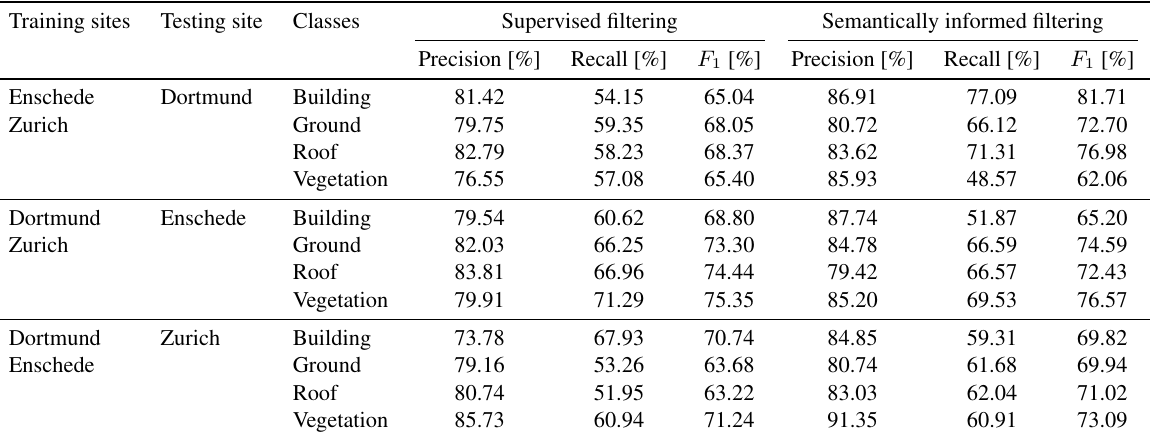
Table 3: Results for filtering approaches trained on two data sets and applied to the third. Note that classes that appear in only one of the data sets (fields in Dortmund, water in Zurich) are not